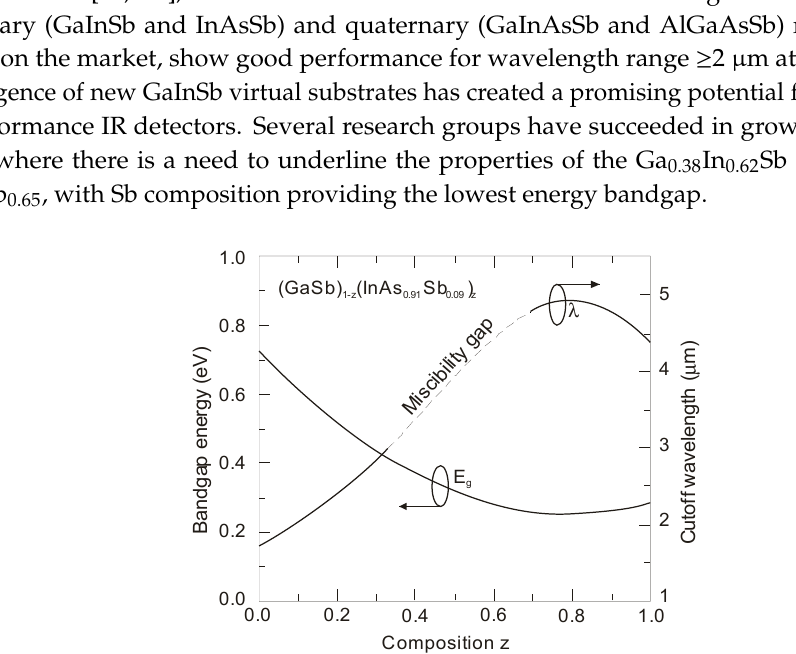
29 of 74 Figure 31. Minority carrier lifetimes versus doping concentration for LWIR HgCdTe and T2SLs at 77 K. Theoretical trend lines for n-type and p-type HgCdTe are taken from [115]. The dashed line for T2SLs follows experimental data. In lightly doped n- and p-type HgCdTe, the SRH mechanism determines the carrier lifetime. Generally, values of τ SRH are approximately more than two orders of magnitude larger for HgCdTe than those reported for the III-V semiconductors with similar bandgaps. At lower temperatures and doping level below 10 14 cm -3 , the HgCdTe P-i-N photodiodes become depletion limited due to SRH centers having lifetimes in the range to 10 ms [116,117]. In consequence, the potential properties of